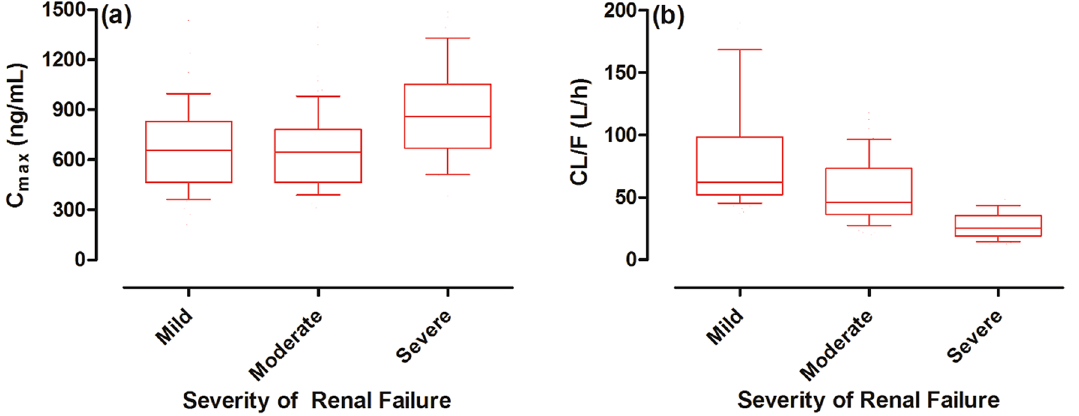
Figure 7. Box plots showing the median, 25th–75th, and 10th–90th percentiles for C max and CL in CKD populations. ( a ) Maximum systemic concentration (C max ), and ( b ) the oral clearance (CL/F) in mild, moderate, and severe renal failure